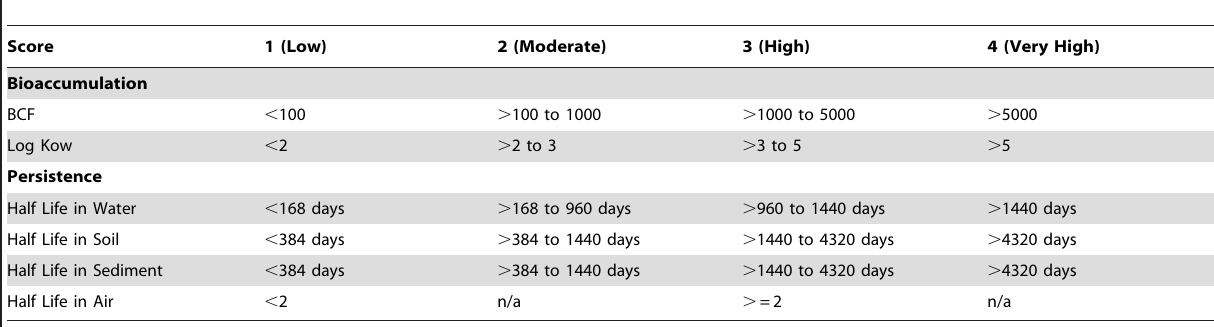
Table 1. Thresholds for Bioaccumulation Potential and Environmental